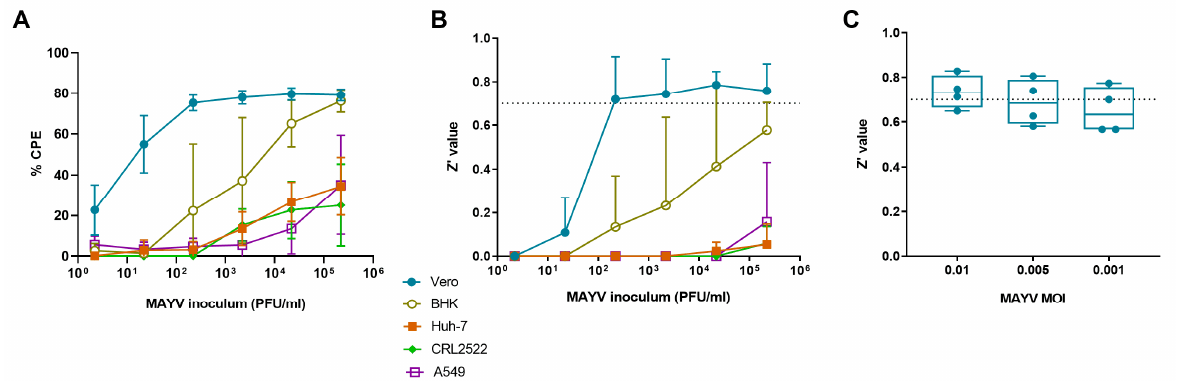
Figure 1. Optimization of a CPE-reduction antiviral assay. ( A ) Percentage CPE and ( B ) Z’ value per MAYV inoculum in different cell lines (Vero, BHK, Huh-7, CRL2522 and A549 cells). Results were obtained with the MTS/PMS read-out method. Mean values ± standard deviations (SD) are shown of 3 independent experiments. CPE, cytopathogenic effect; PFU, plaque-forming unit. ( C ) Z’ value for three different MAYV inocula (MOI 0.01, 0.005, 0.001) on Vero cells. Data are presented as box plots showing individual and mean values of four independent experiments. MOI, multiplicity of